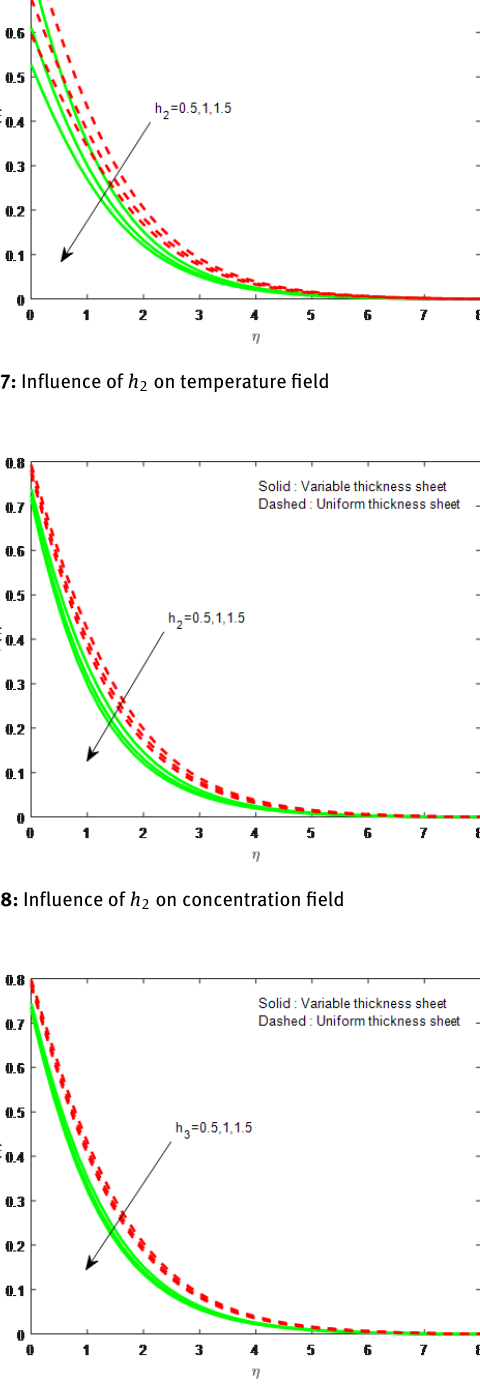
Fig. 19: Influence of h 3 on temperature field